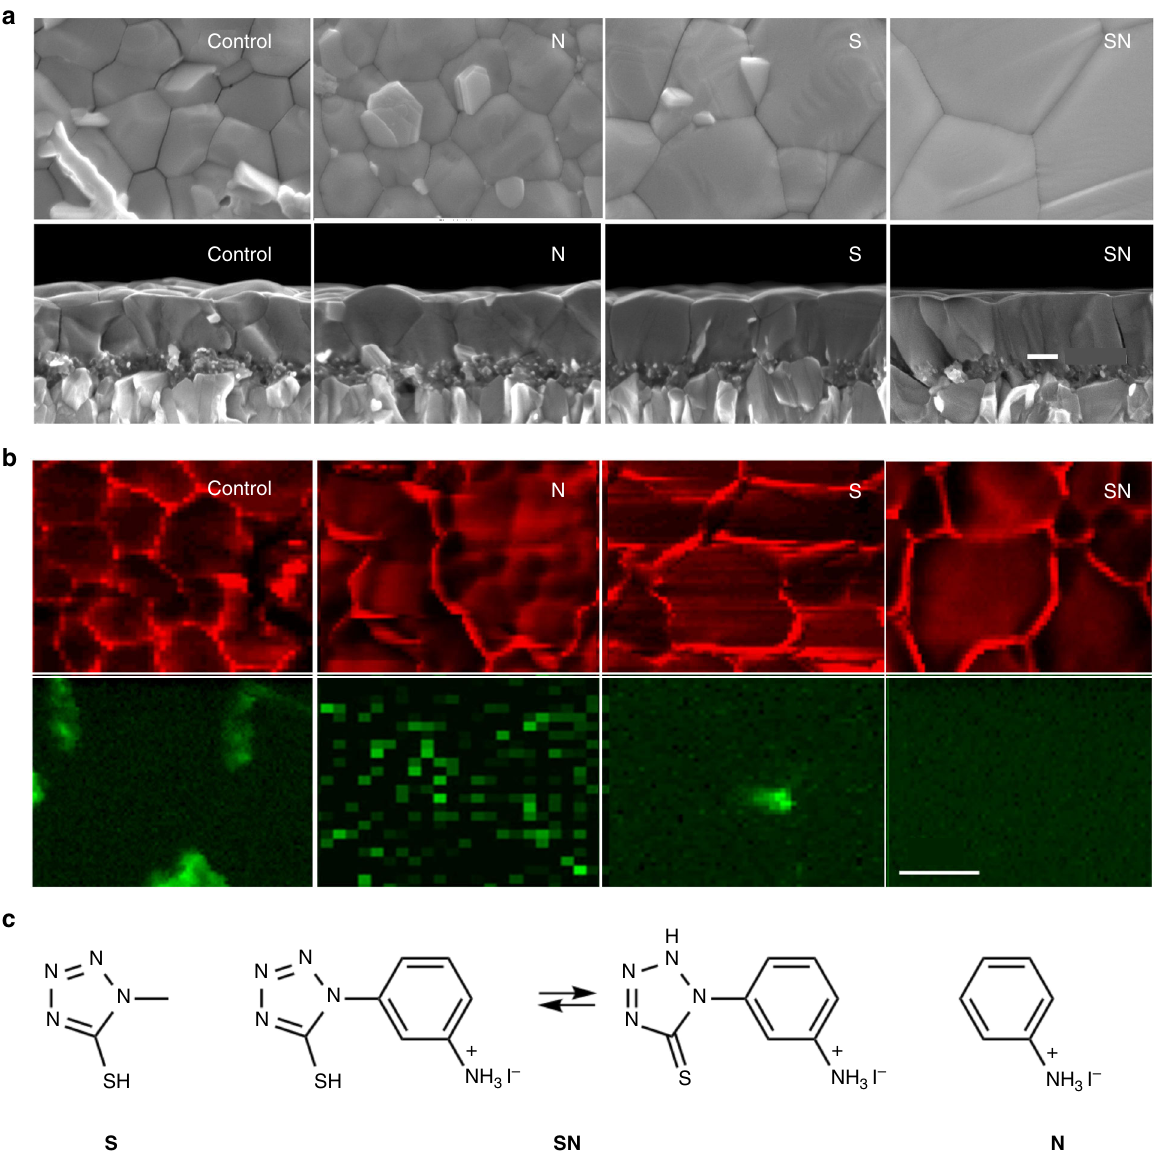
Fig. 1 Structural characterization of modulated perovskite fi lms. a Plane-view (top) and cross-sectional (bottom) SEM images of the pristine (control) and modulator-containing (N, S, and SN) perovskite fi lms deposited on the mesoporous-TiO 2 /compact-TiO 2 /FTO. Scale bar represents 200 nm. b Cathodoluminescence (CL) mapping of the pristine (control) and additive-containing (N, S, and SN) perovskite fi lms deposited on the ITO (1 mm) glass substrates. The spatial distribution of green and red light emission, recorded from 530 to 590 nm and from 700 to 800 nm, respectively, reveals the microscopic distribution of PbI 2 phase in the perovskite fi lms. Scale bar represents 1 µ m. c Structure of N, S, and SN modulators employed in the study, with the corresponding tautomeric forms of SN (the geometries optimized by DFT calculations at B3LYP/6-31 G(d) level of theory are provided in Supplementary Figure 1, whereas the corresponding NMR spectra are shown in Supplementary Figures 2 – 5 that reveal the predominance of the